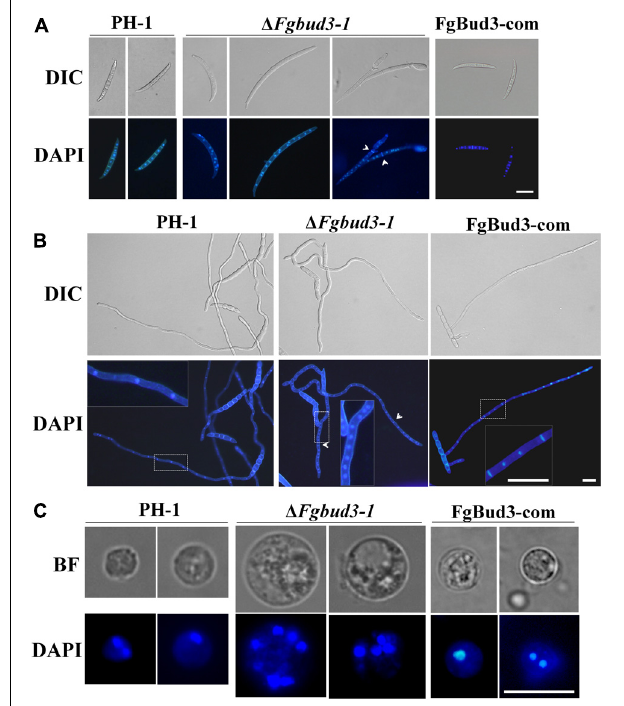
FIGURE 4 | The nuclear division phenotype of the FgBUD3 deletion mutant. Conidia (A) or hyphae (B) of PH-1, (cid:49) Fgbud3-1 and FgBud3-com were stained with 4 (cid:48) ,6-diamidino-2-phenylindole (DAPI) and examined by microscopy under DIC or UV light. The arrows indicate septa. Bar = 20 µ m. (C) Protoplasts of each strain were stained and examined. Bar = 10 µ m.